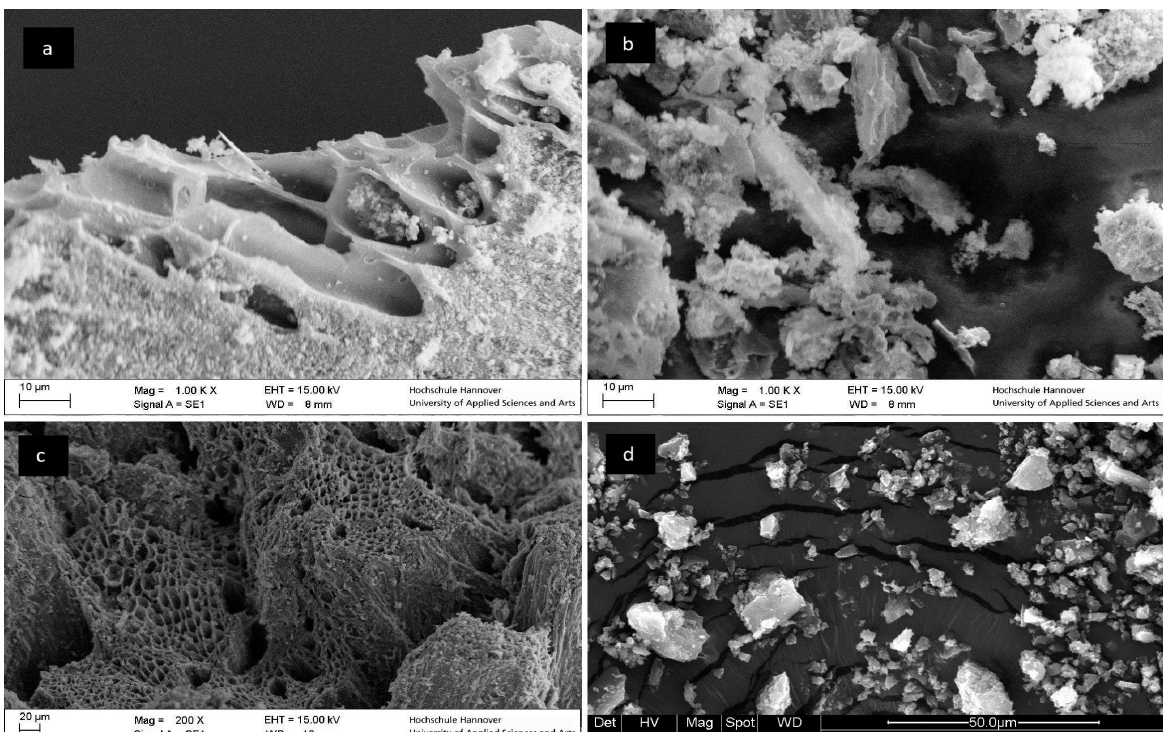
Figure 3. ( a ) Micro-morphological details from ESEM analysis on “as-received” biochar grain 1000× magnification; ( b ) sifted ”as-received” biochar powder, ESEM, 1000× magnification; ( c ) cleaned biochar pellet surface, ESEM, 200× magnification; ( d ) biochar particles after cleaning and sieving processes (applying 32 µm mesh).